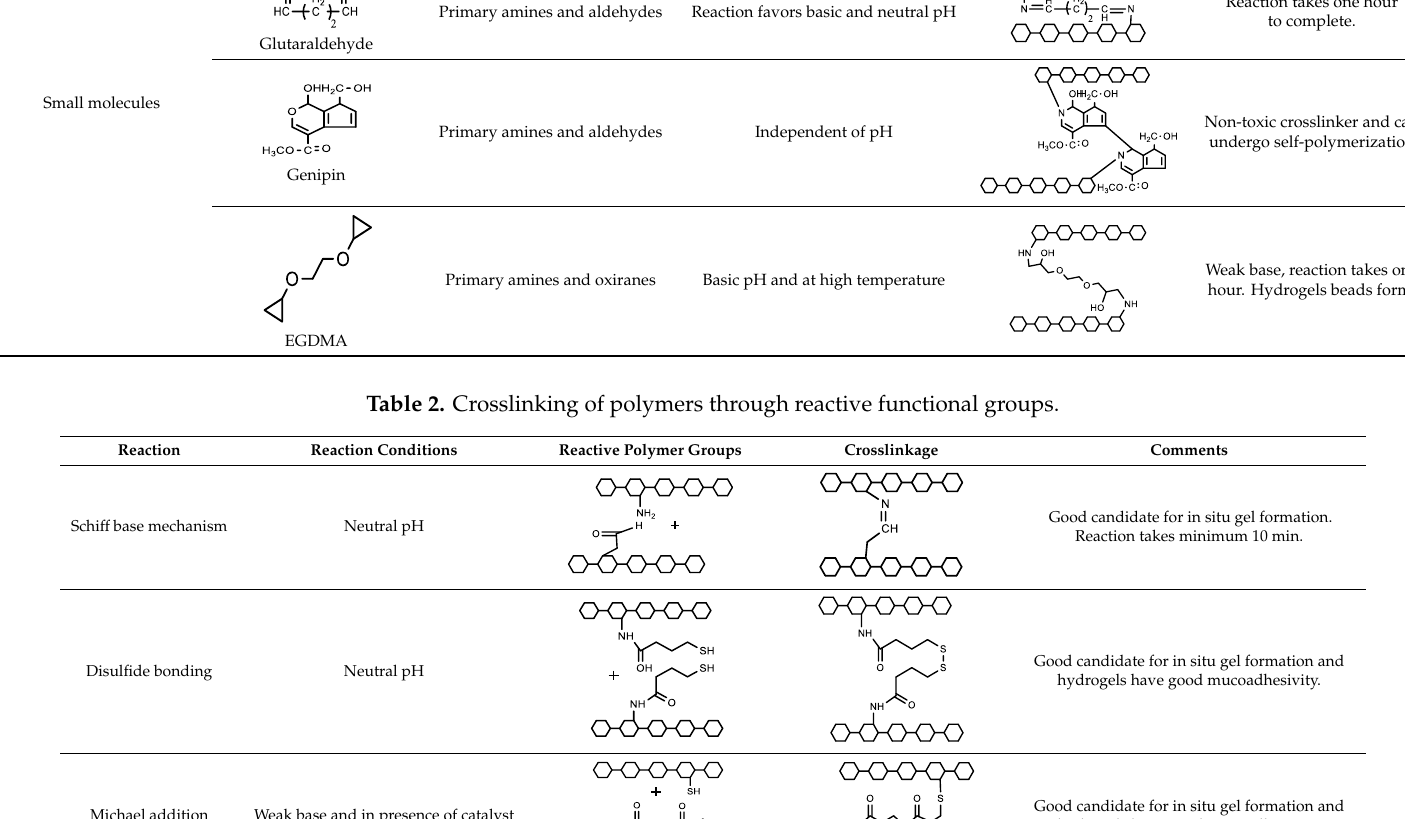
remove trace formaldehyde. Reaction takes one hour to complete.